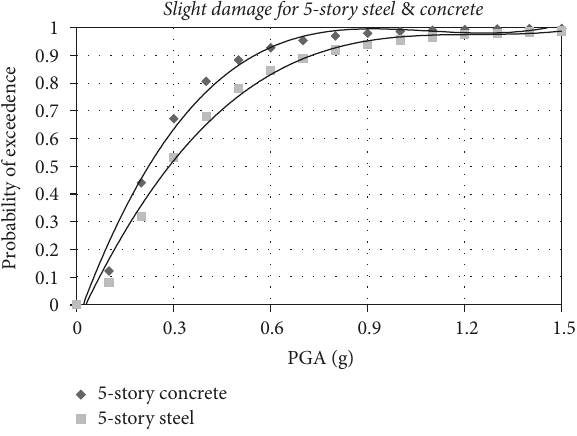
Figure 14: Comparison of the fragility of the 5-story steel and RC frame buildings for the complete damage